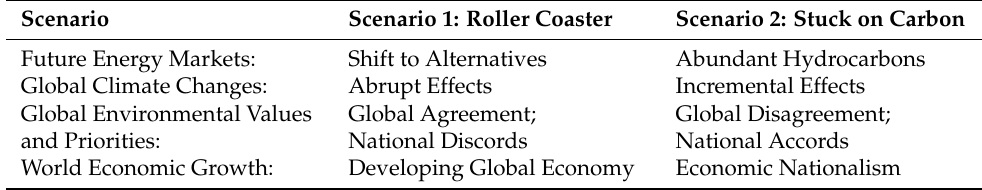
Table 2. Two alternate energy/environment scenarios of the future. Scenario Scenario 1: Roller Coaster Scenario 2: Stuck on